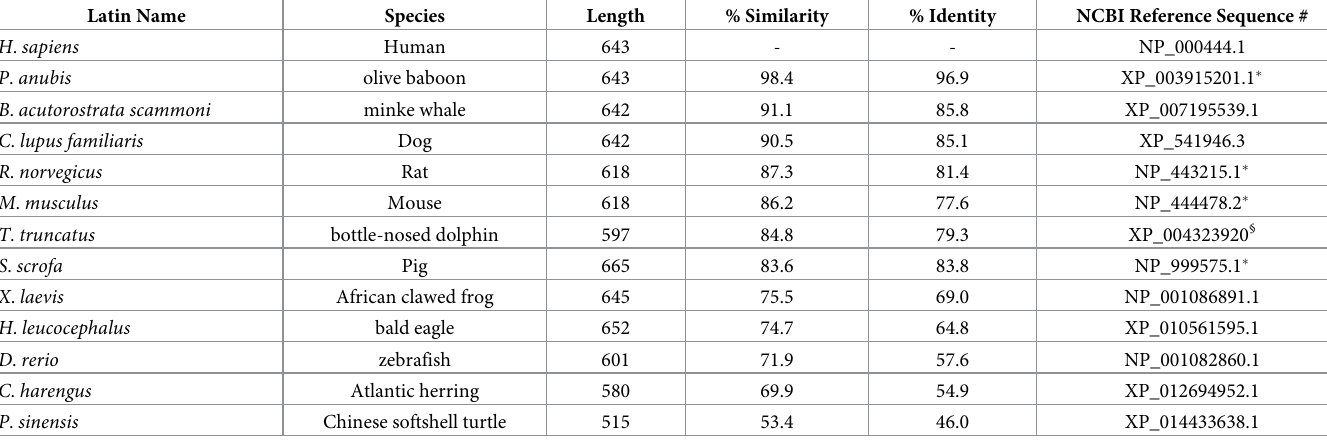
Table 2. Properties of NIS proteins